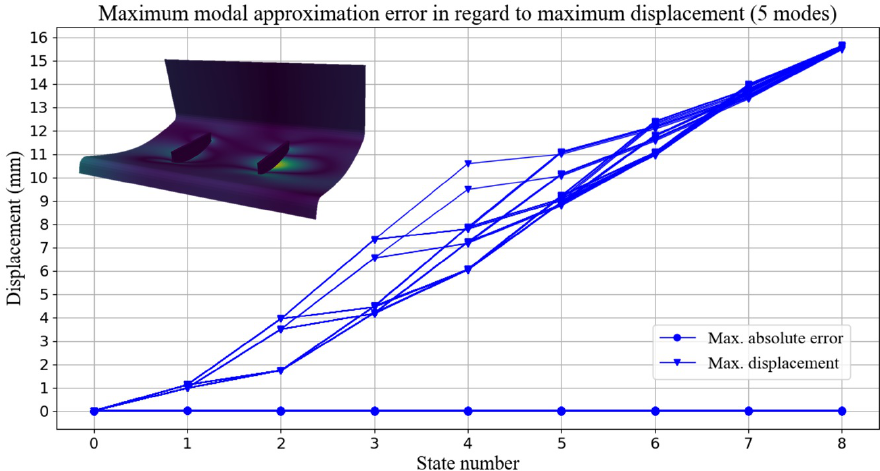
Figure 7. Graph: Maximum modal approximation error with respect to the maximum displacement when using five modes. Picture: Reduced approximation of the deformed structure (displace- ments ×